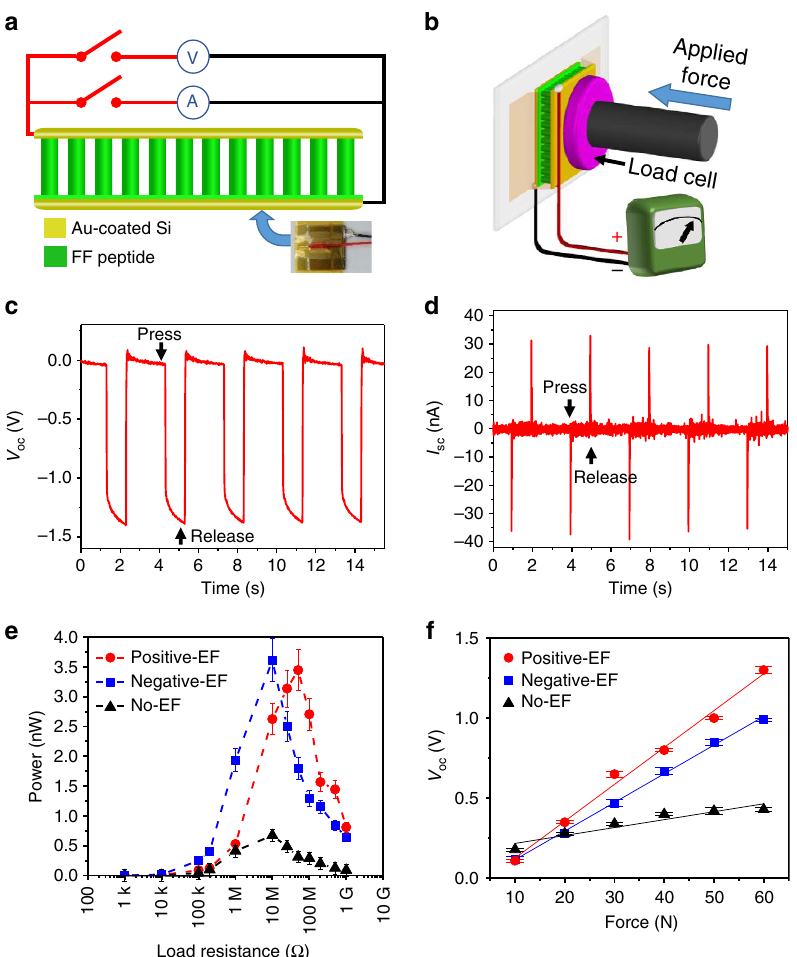
Figure 3 | Characterization of the FF peptide-based power generators. ( a ) Schematic of the FF peptide-based generator connected to the measurement equipment. Bottom-right inset: photography of a real device. ( b ) Schematic of the measurement set-up in which a linear motor pushes with controlled forces on the top electrode in ( a ). The linear motor was programmed to always keep contact with the top electrode to minimize the effect of static charges. ( c , d ) Open- circuit voltage ( c ) and short-circuit current ( d ) from a generator using microrods from positive-EF growth. ( e ) Dependence of the power output from the generators on the resistance of the external load under 50 N applied force. ( f ) Linear dependence of the open-circuit voltage on the applied force. Error bar: